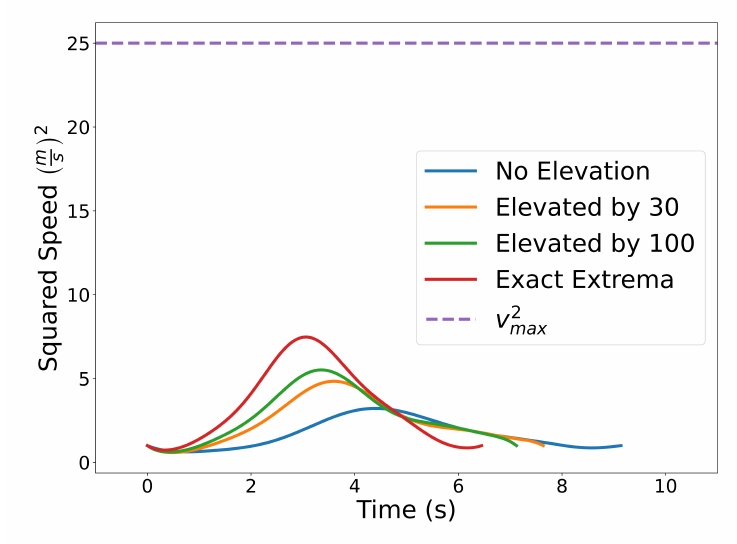
Figure 24. Plot of the squared speed constraints for each separate